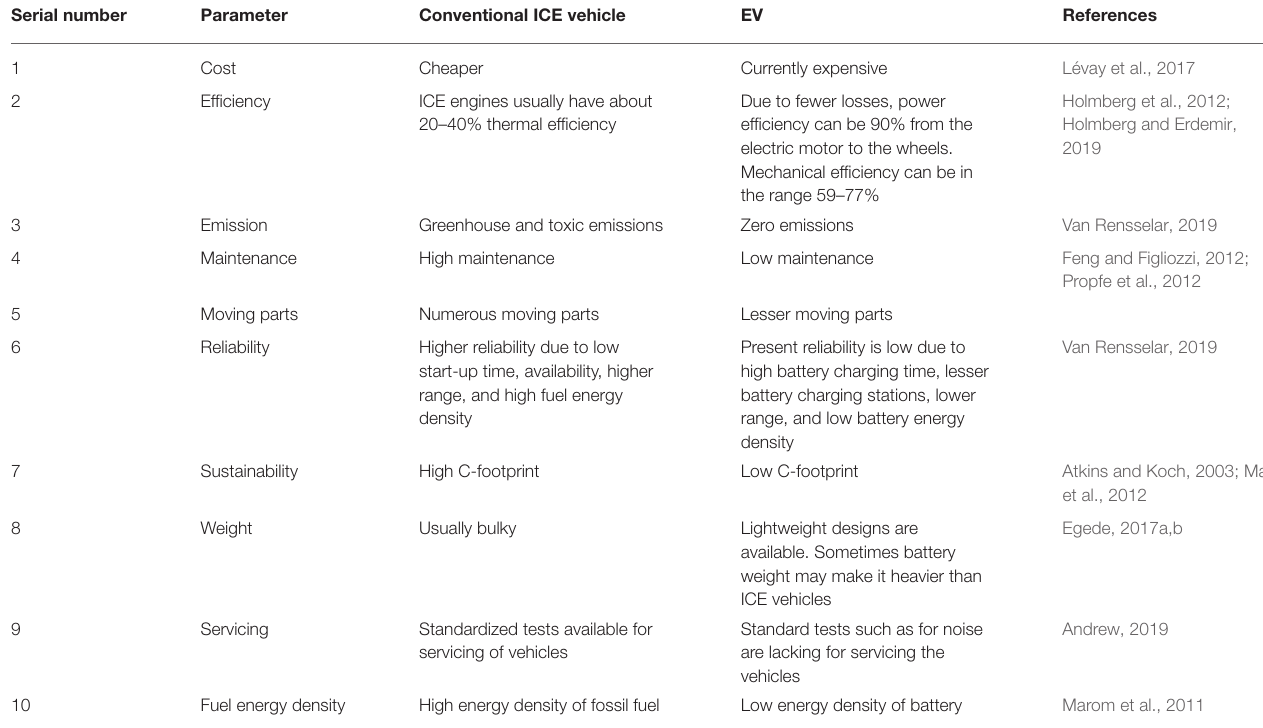
TABLE 1 | Comparison of conventional ICE vehicles and the EV/HEV